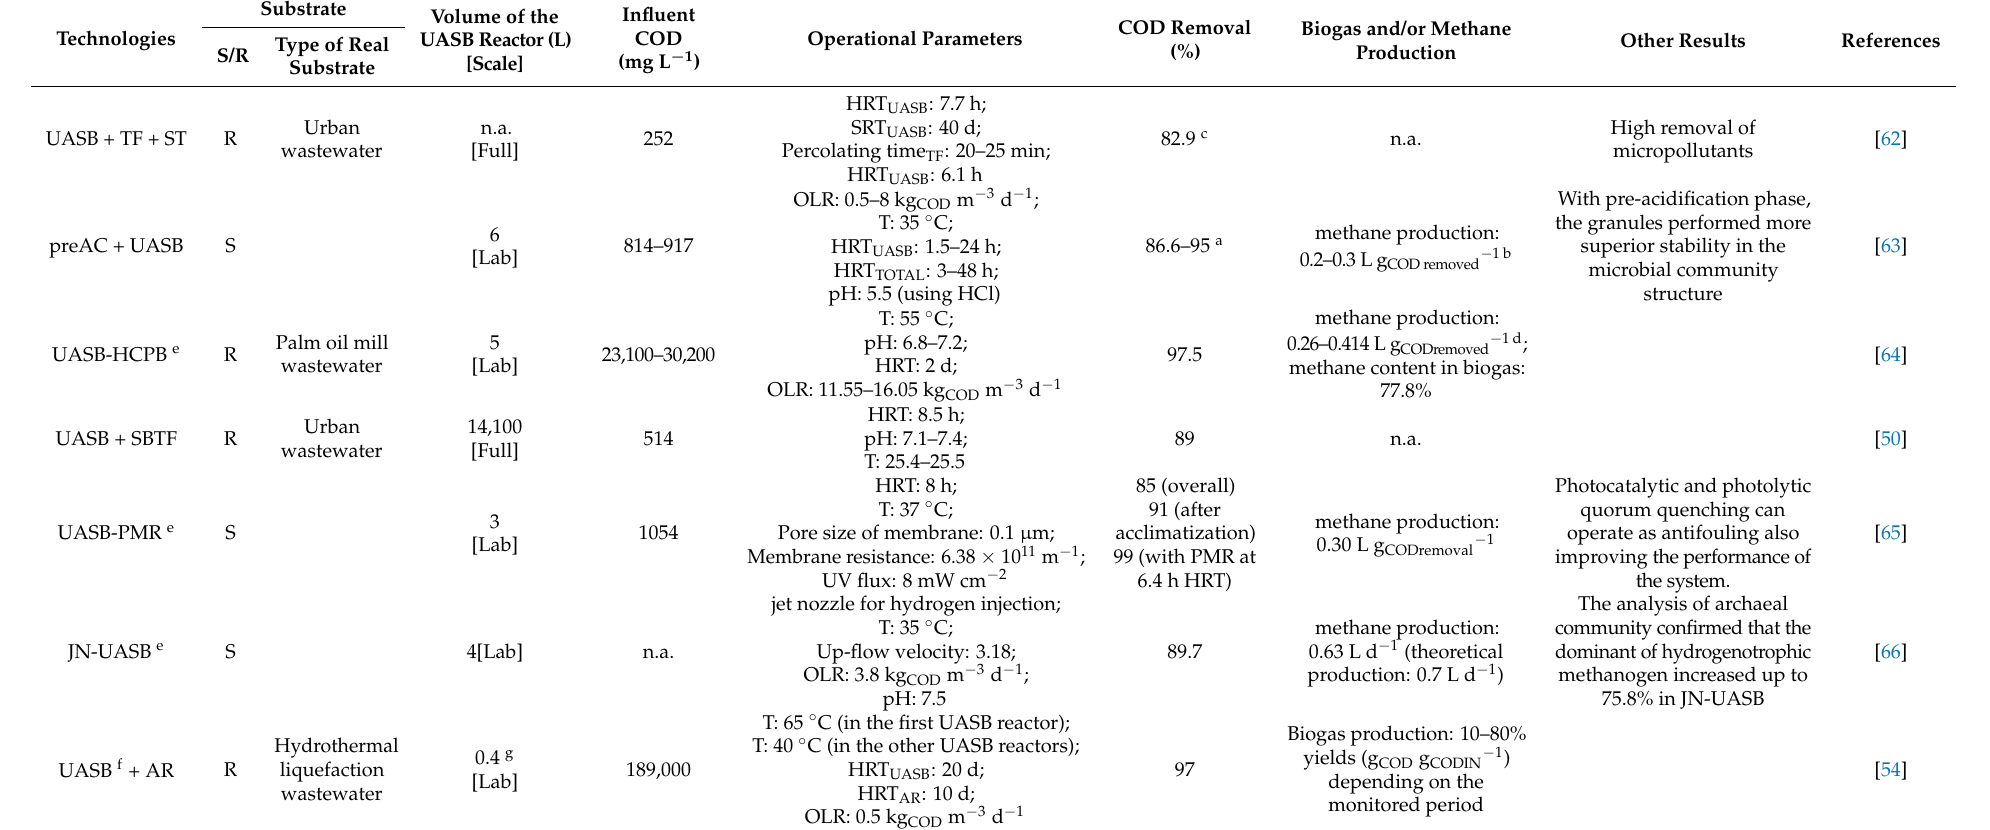
Table 2. Several applications of UASB coupled with other treatment phases for organic substance removal and biogas production. S: Synthetic substrate; R: real matrix. n.a.: not available; TF: Trickling filters; ST: Sedimentation tank; preAC: Pre acidification in continuous-flow stirred reactor; HCPB: hollow centred packed bed; SBTF: Sponge-bed trickling filters; PMR: Photocatalytic membrane reactor; JN: Jet-nozzle; AR: Aerobic reactor; ABF: anaerobic biofilter; BE-UASB: bioelectrochemical UASB; AnMBR: anaerobic membrane bioreactor; GAC: Granular activated carbon; LBR: Leaching bed reactor; DHS: Downflow hanging sponge. a : referred only to soluble COD; b : value deduced by figure analysis; c : value deduced by the comparison of influent and effluent data; d : value reported following equivalence of units of measure; e : in the same reactor; f : five in series; g : for each UASB; h : system composed of a mixed reactor (hydrolysis and acidogenesis) and a UASB reactor